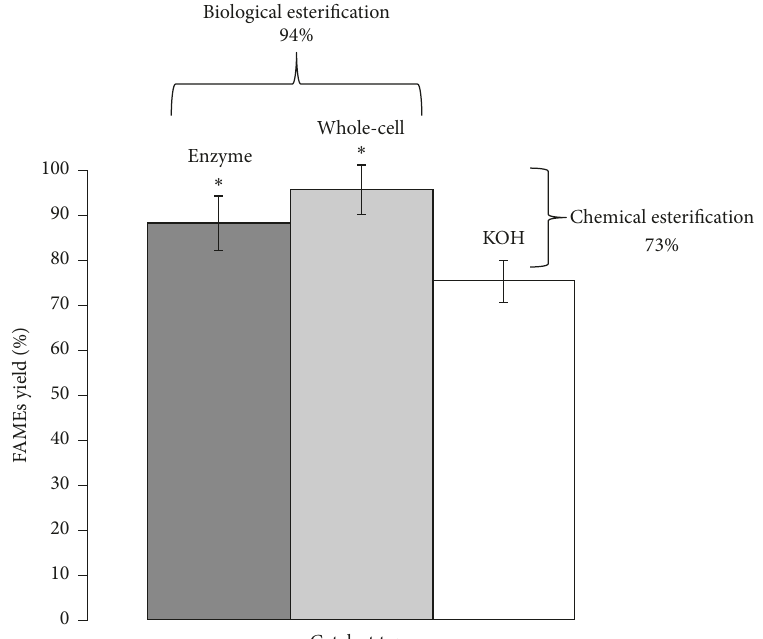
Figure6:FAMEsyieldestimatedforbothchemicalandbiologicaltransesterification.Dataaremeans ± SDofthreeindependentexperiments. ∗ Difference is not that significant by the Tukey’s post hoc tests ( 𝑝 < 0.05 ).